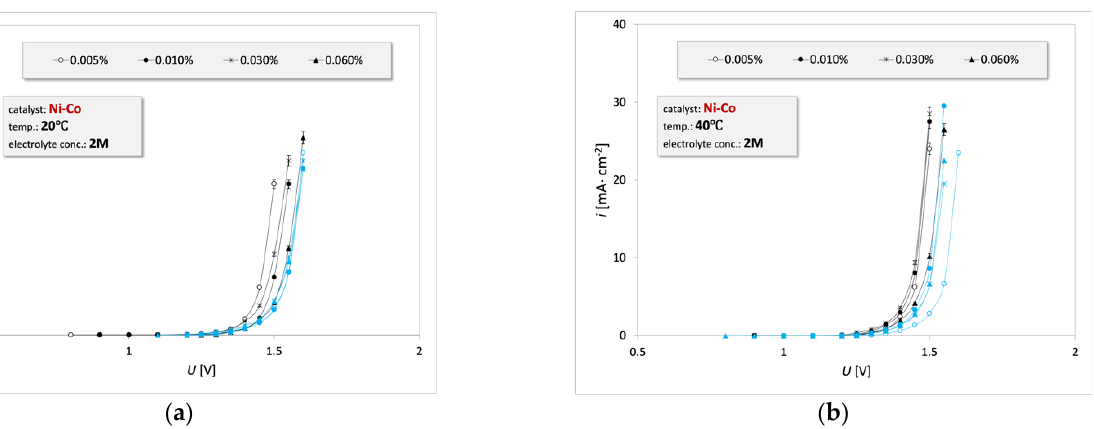
Figure 8. Electrooxidation curves of WEO emulsion (black lines) and detergent (blue lines) for various concentrations of detergent and emulsion on the Ni-Co catalyst for an electrolyte concentration of 2 M. Electrooxidation: ( a ) temperature: 20 °C; ( b ) temperature: 40 °C.